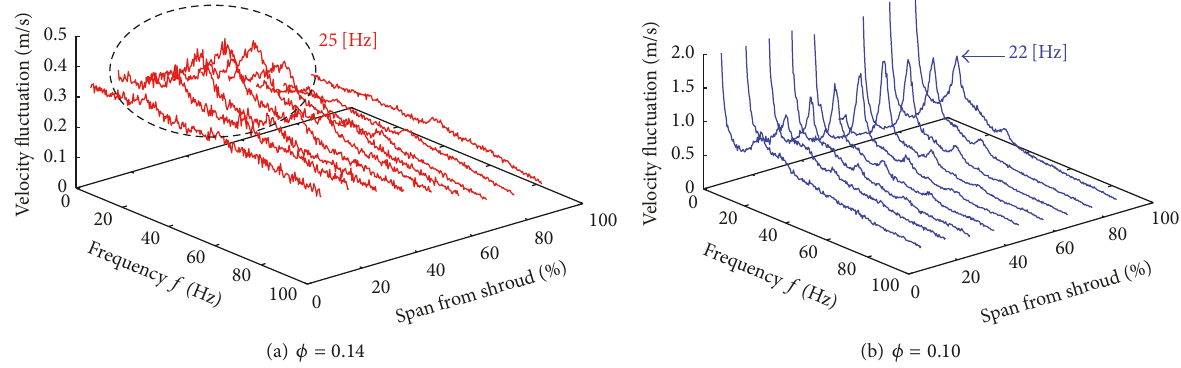
Figure 5: Distribution of velocity fluctuation in spanwise direction (ODV).